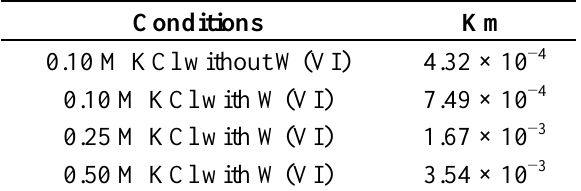
Figure 2. Lineweaver-Burk double reciprocal plot in presence and absence of W(VI) as inhibitor. Table 4. Michaelis-Menten apparent constant values at different KCl